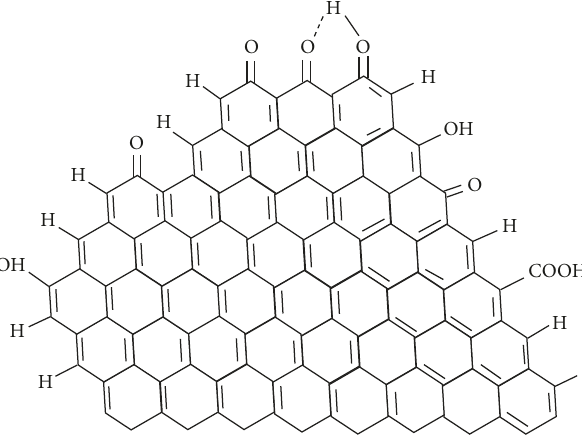
Figure 3: The molecule structure of CB [37].